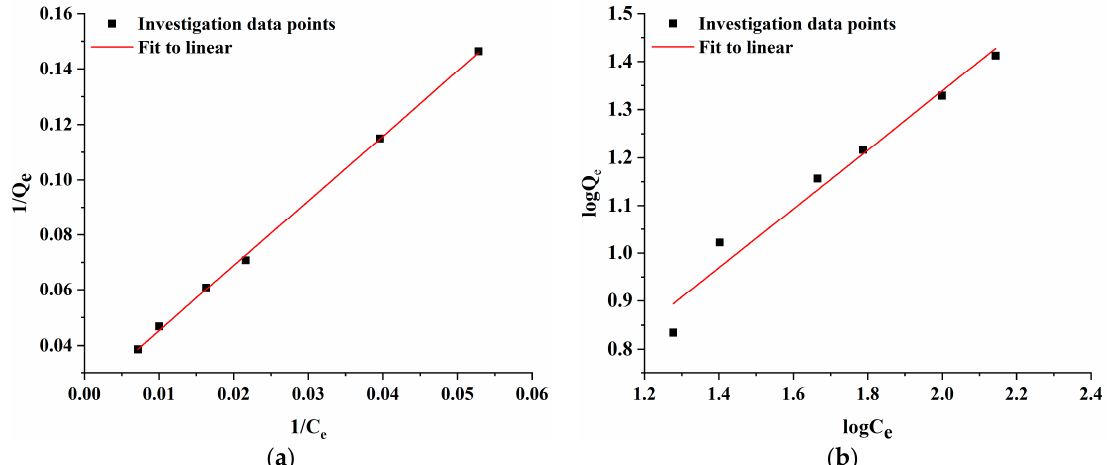
Figure 7. The linear fitting of Langmuir isotherm model ( a ) and Freundlich isotherm model ( b ) for adsorption kinetics.